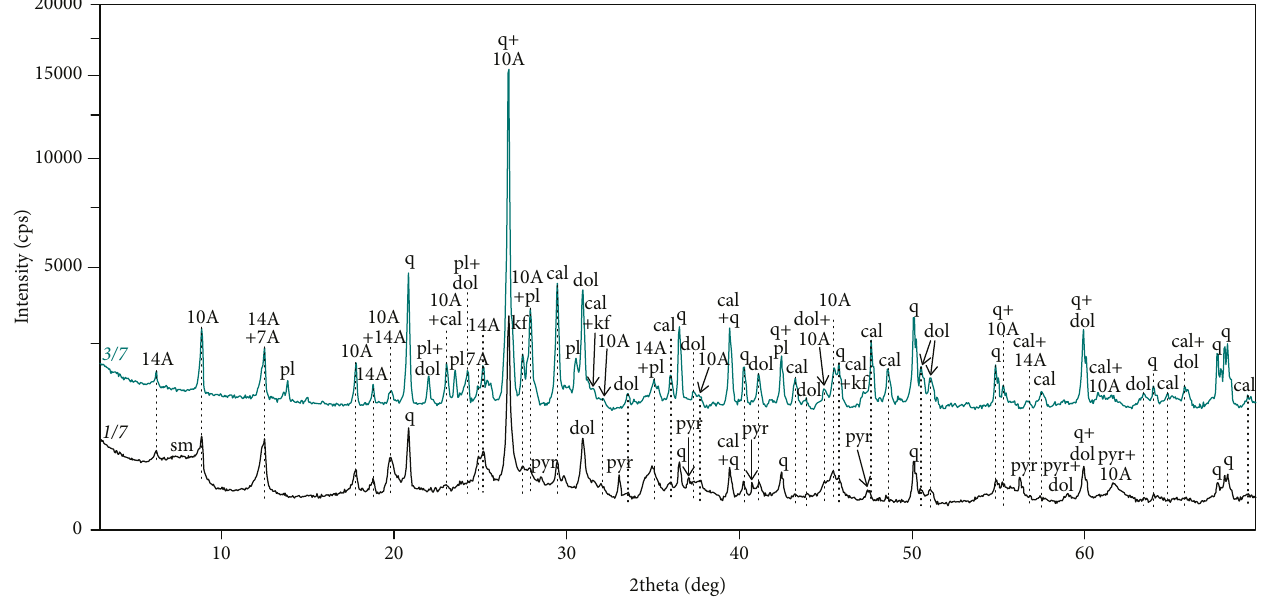
Figure 6: Typical XRPD patterns of representative bulk rock samples (sample 3/7: sandstone; sample 1/7: pyrite-bearing mudrock). Abbreviations: 14A=14 Ångström phase (chlorite ± vermiculite ± smectite); 10A =10 Ångström phase (illite ± mica); 7A=7 Ångström phase (kaolinite); cal =calcite; dol=dolomite; kf =K-feldspar; pl =plagioclase feldspar; pyr=pyrite; q =quartz; sm=smectite ± highly swelling mixed-layer